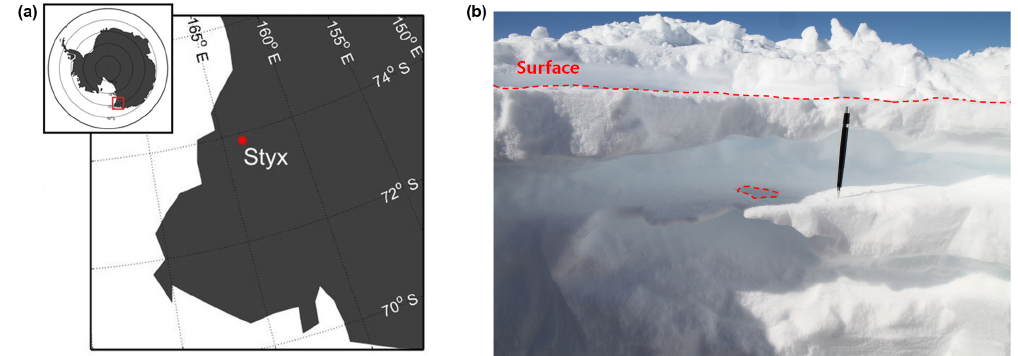
Figure 1. (a) Location map of study site, Styx Glacier, Antarctica, and (b) a photo of surface snow density layers. The thickness of the snow density layers varies horizontally. The top boundaries of the high-density layers are sharp (horizontal red dashed line). A hole on a high-density layer surface is indicated by a red dashed circle. The length of the black sharp pencil in panel (b) is